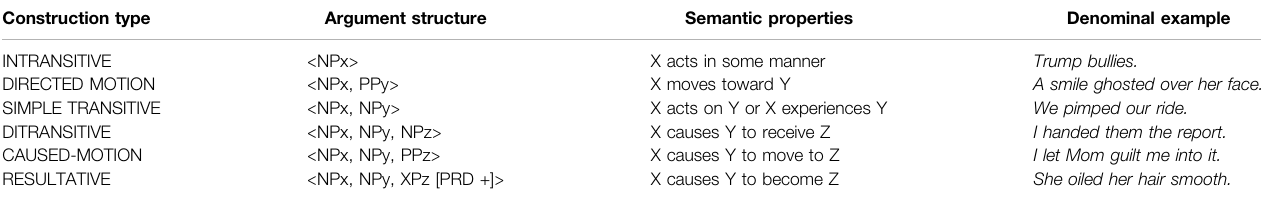
TABLE 2 | Argument-structure constructions (adapted from Goldberg 1995 ) Construction